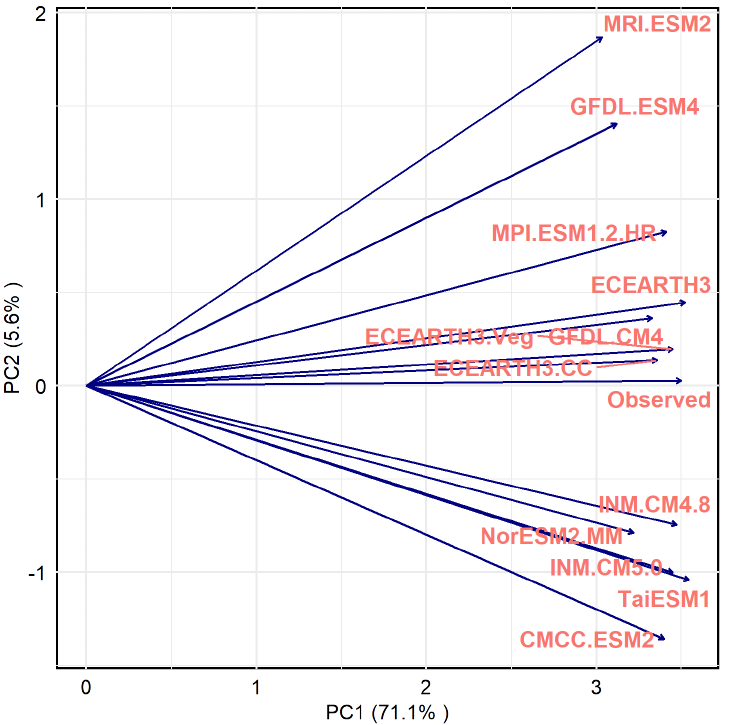
Figure 7. PCA biplot for the monthly maximum temperature series of the observed and climate model series. The Figure on the left is a zoomed-out part of the main biplot on the